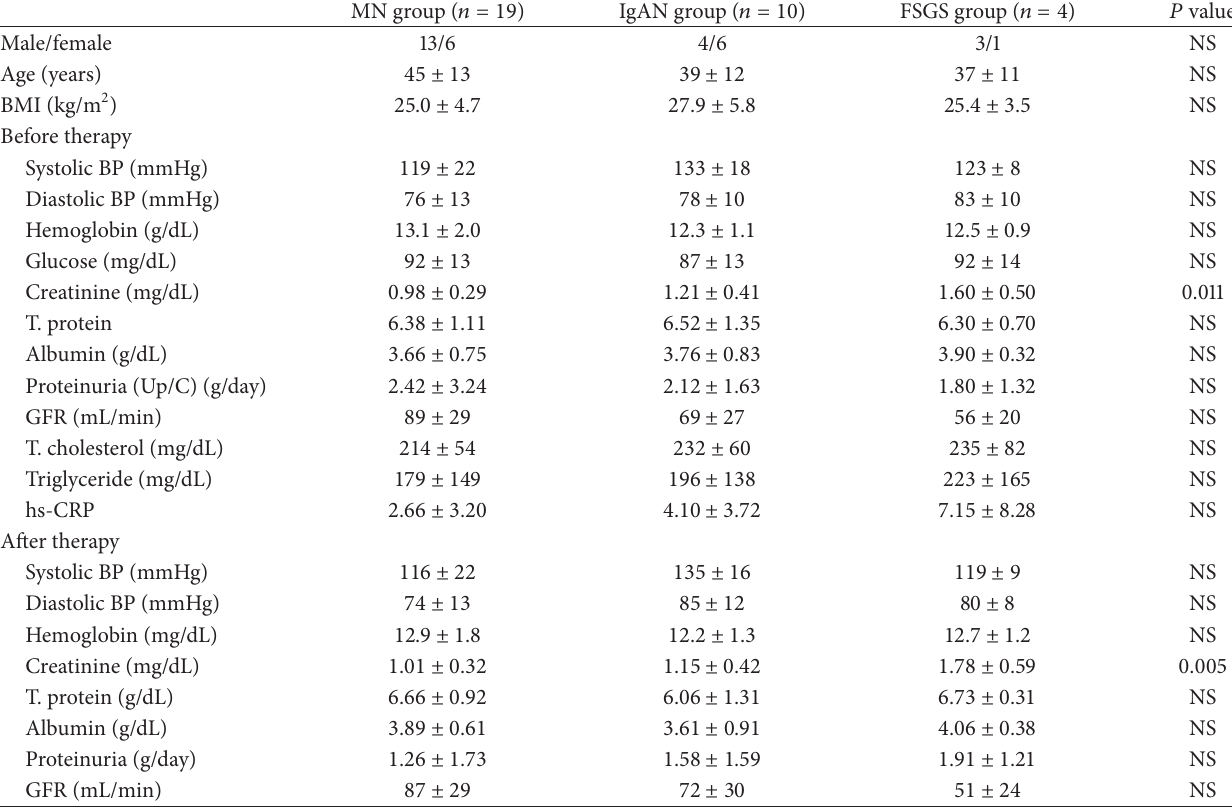
Table 2: Clinical and laboratory features of the patients before and after H. pylori eradication